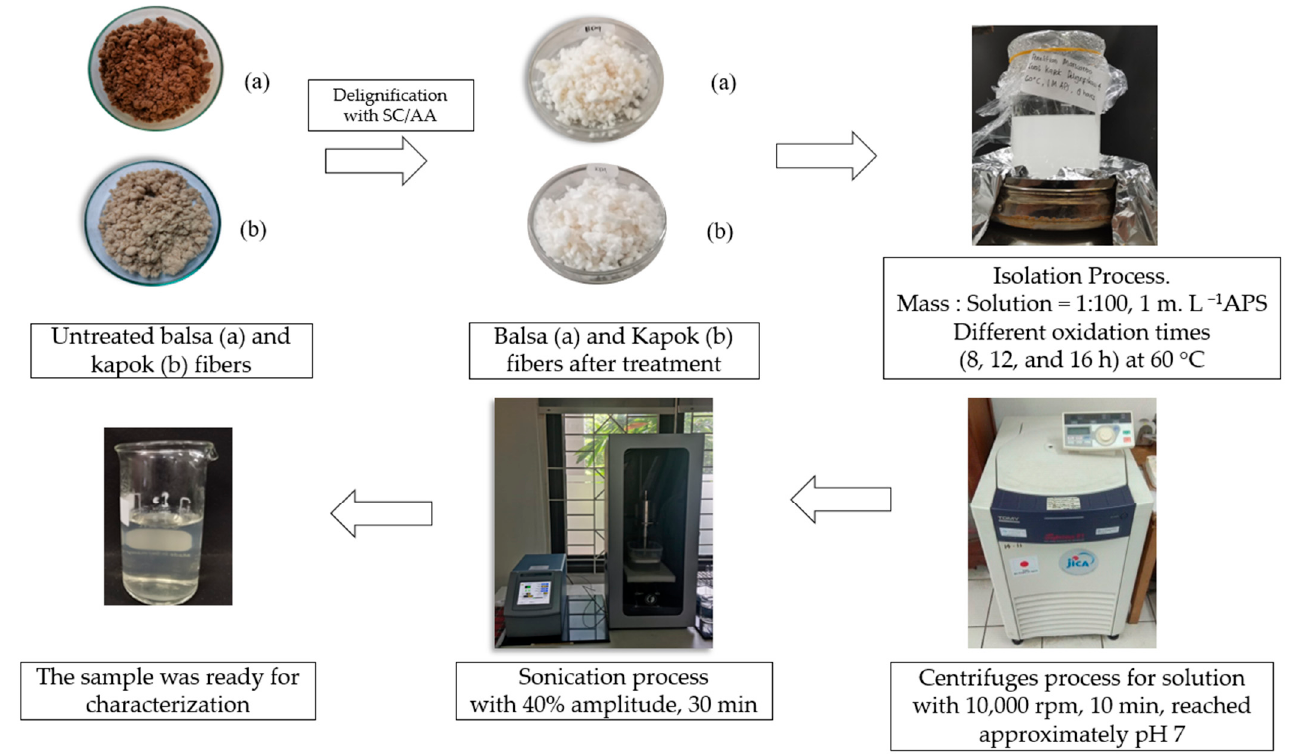
Figure 1. Isolation process of CNCs with the APS oxidation method.